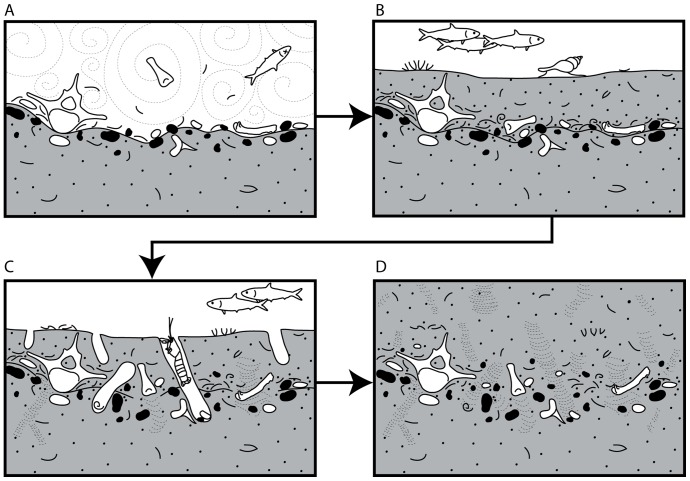
The effects of bioturbation on cross-sectional bonebed geometry.(A) Erosion winnows coarse, dense material and bioclasts onto an erosional surface. (B) A return to positive sedimentation results in burial of the lag concentration. (C) Subsequent bioturbation by burrowing organisms and other infauna erase the erosional surface and transpose bioclasts. (D) The resulting concentration may be misinterpreted as a hiatal bonebed.